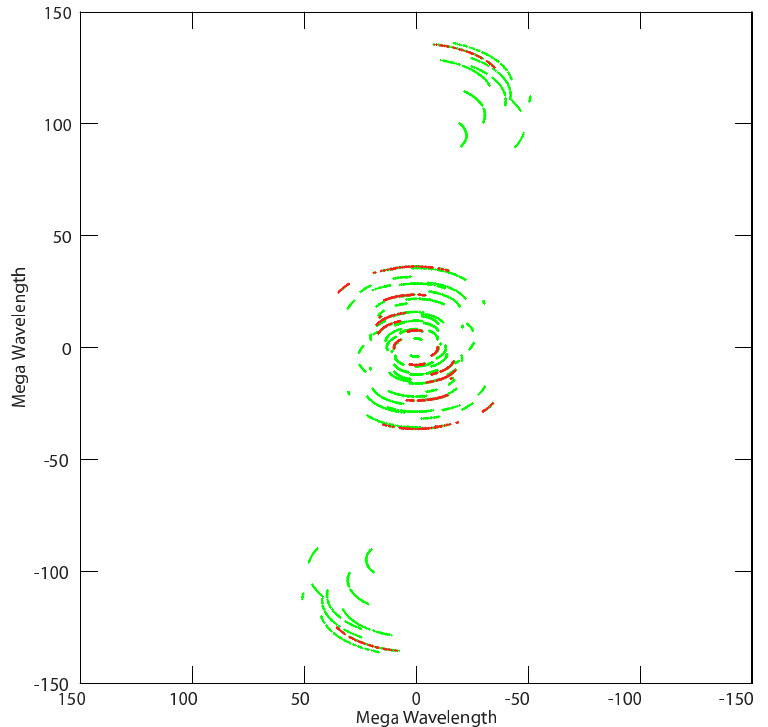
Fig. 1. The u , v plane coverage of the EVN network (in Mega wavelengths) obtained from observations of the source 0234+285 during the e-VLBI experiment EG069C. Red dots mark the results of the baselines with the Irbene radio